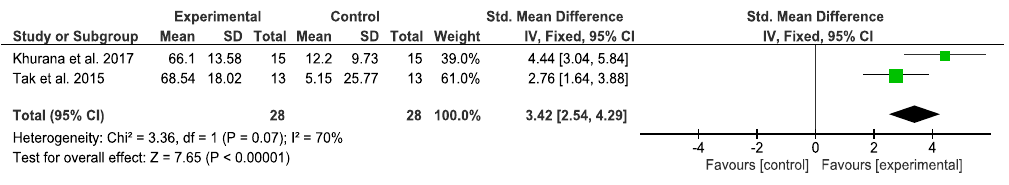
Table 3. PEDro scores obtained by the different studies included in the systematic review.